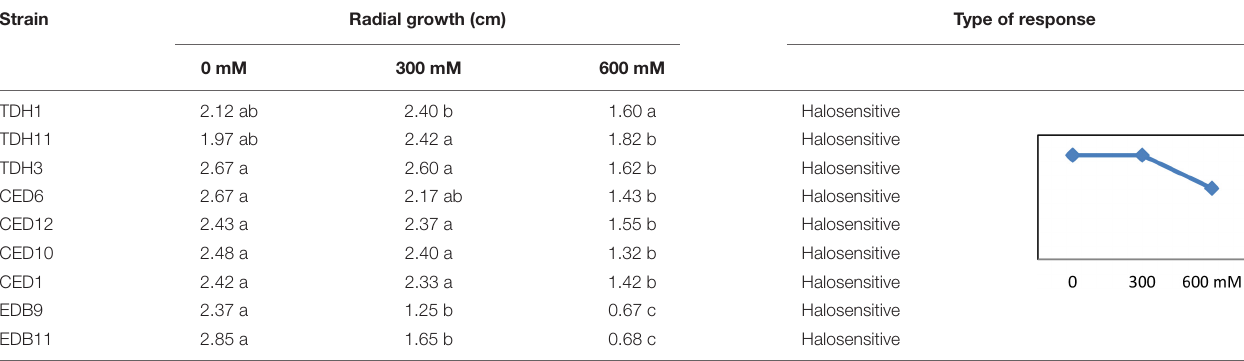
TABLE 5 | Radial growth of nine Epichloë festucae strains isolated from Festuca rubra subsp. pruinosa plants from marine cliffs in PDA plates with different NaCl concentrations. Strain Radial growth